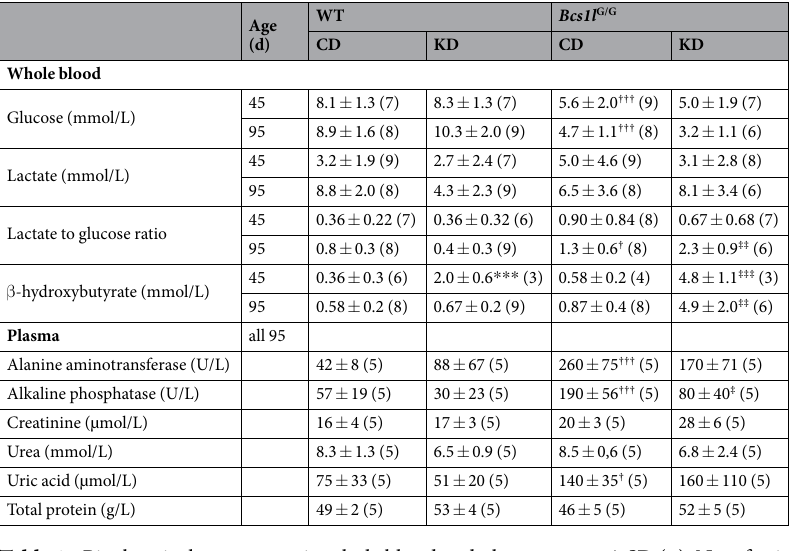
Table 1. Biochemical parameters in whole blood and plasma, mean ± SD (n). Non-fasting blood samples were used for the measurements. Significances p < 0.05, < 0.01 and < 0.001 are indicated for comparisons between WT on CD vs WT on KD ( * , ** and *** ), WT on CD vs Bcs1l G/G on CD ( † , †† , ††† ) and Bcs1l G/G on CD vs Bcs1l G/G on KD ( ‡ , ‡‡ , ‡‡‡ ), respectively. n numbers in